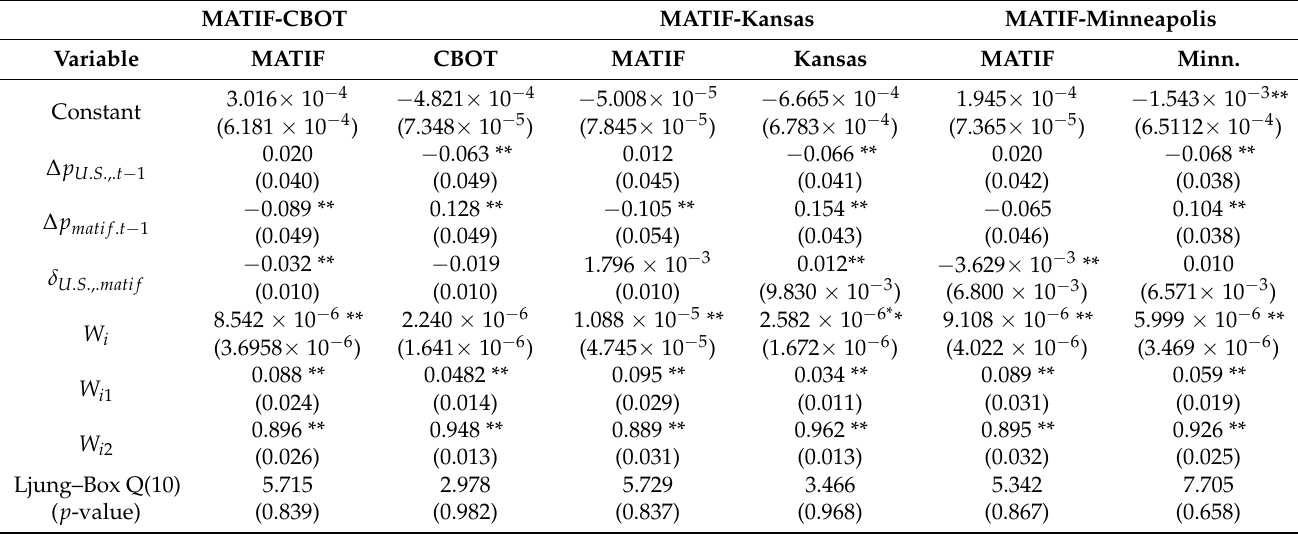
Table 6. Results for the univariate ECM-GARCH (1,1) model for the second period.